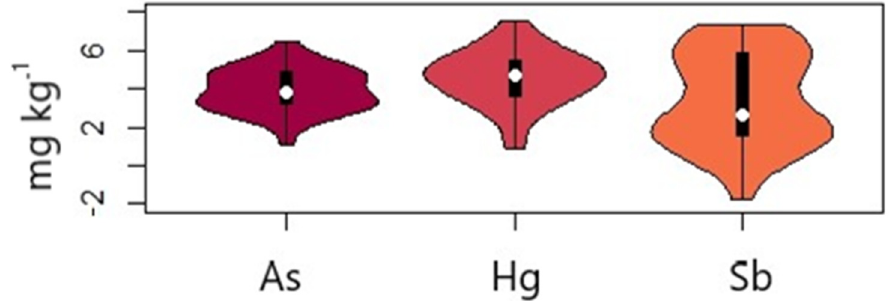
Figure 4. As, Hg and Sb violin plots. The x -axis shows the three metals, the y -axis are the concentra- tions (mg kg − 1 ) expressed as a logarithm.